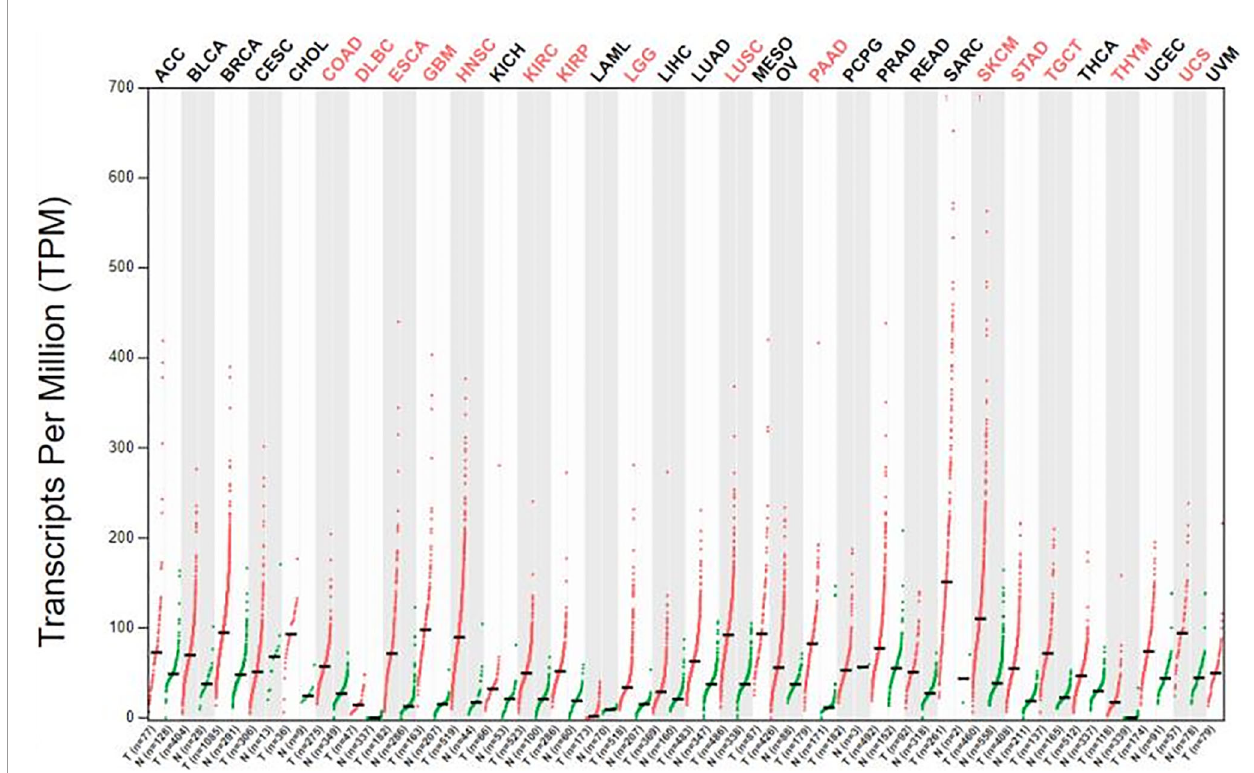
FIGURE 2 | The gene expression pro fi le across all tumor samples and paired normal tissue (dot plot). Labels upward the fi gure show different types of tumor marked different color, red show statistic data have signi fi cant difference, black show statistic data have no signi fi cant difference; The X axis is the number of tumor samples (T) in red and normal samples (N) in green for each tumor. The Y axis is transcripts per million (TPM). gepia.cancer-pku.cn